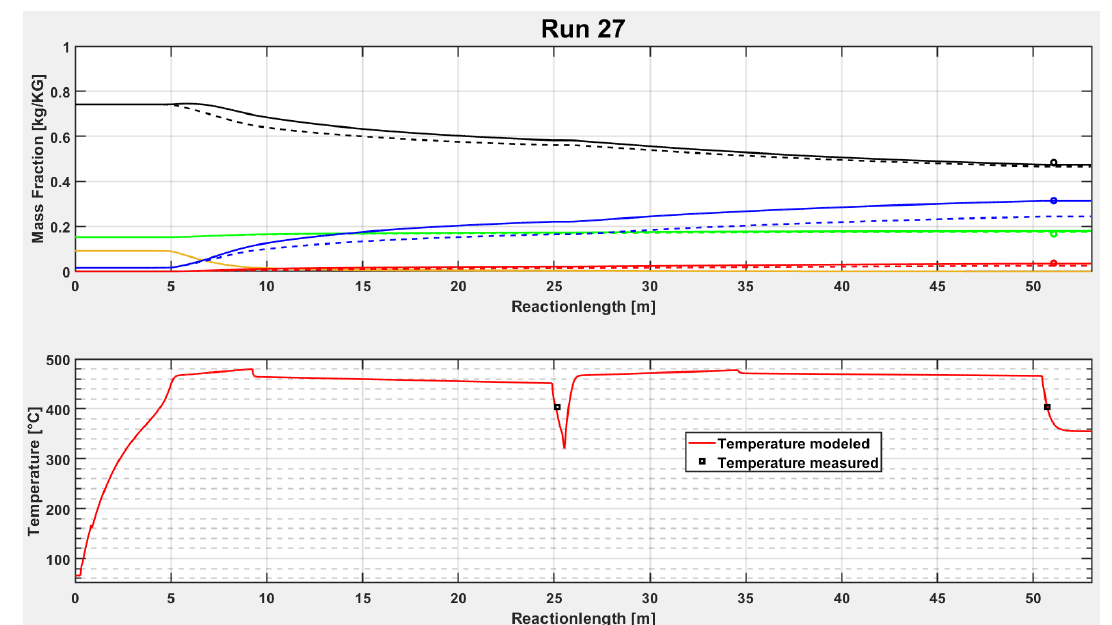
Figure 6. Trends of mass fraction of the lumps and the temperatures over the reactor length for test run 27 with 10% PP.